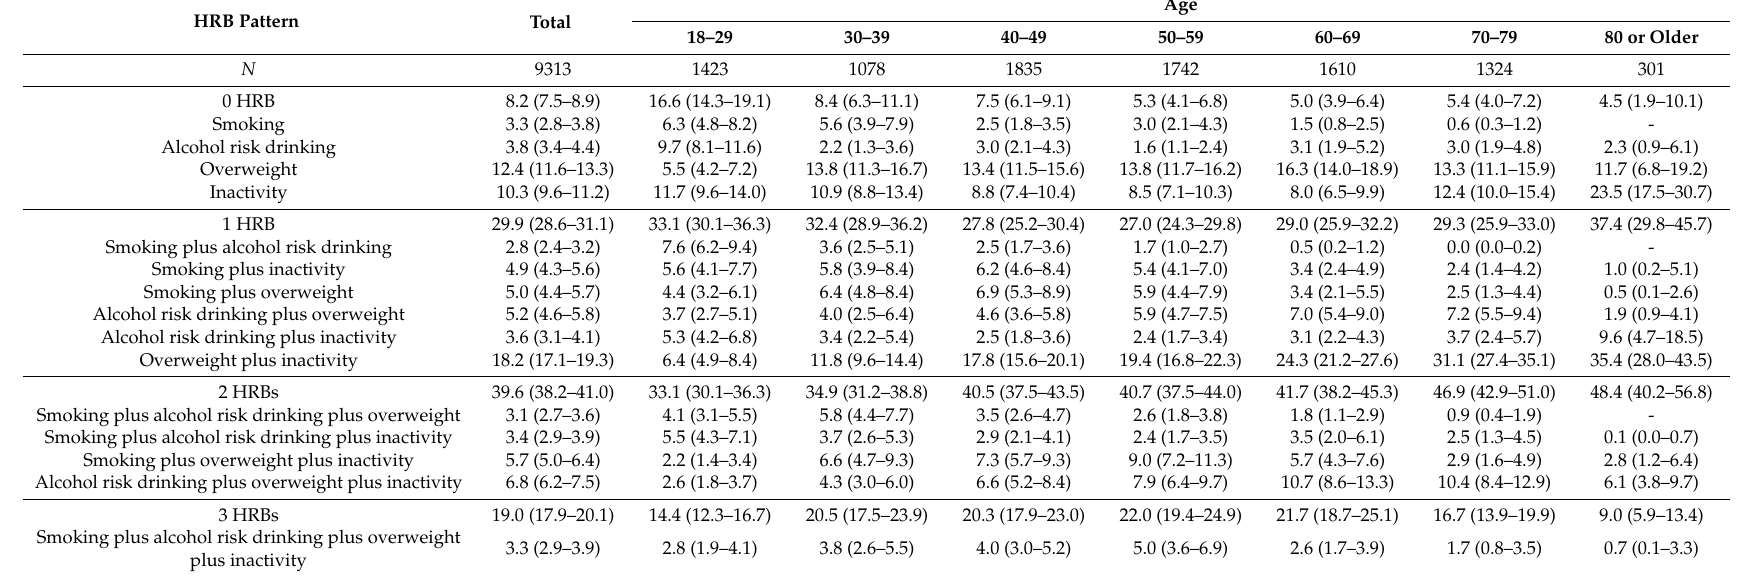
Table 2. Multi-behavior risk constellations males, % (95% confidence